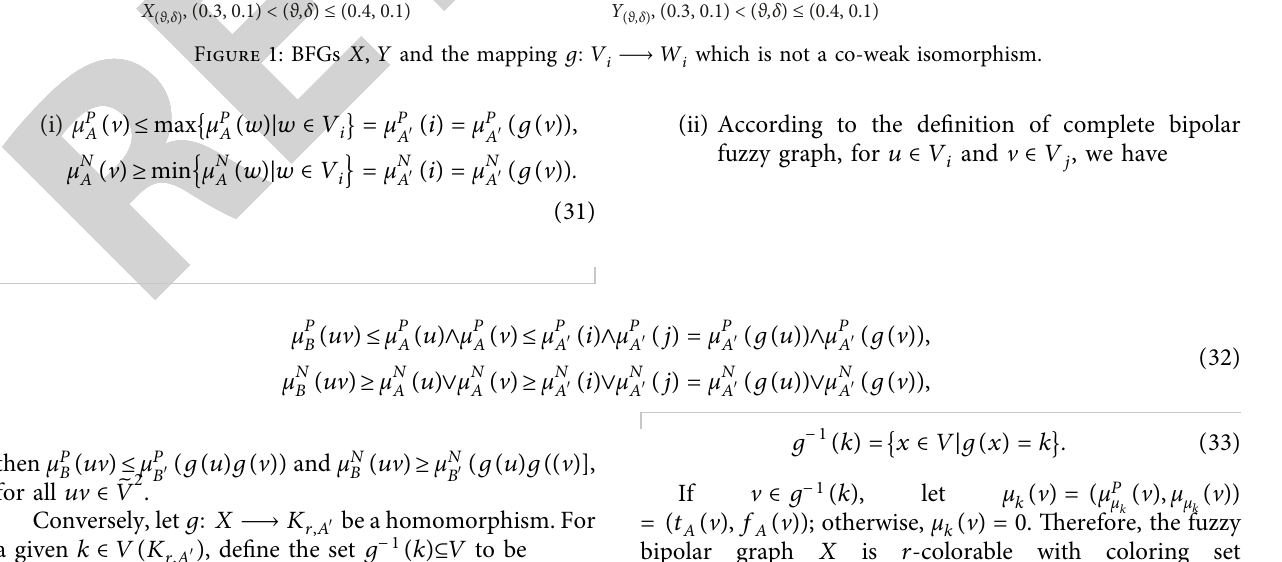
Figure 1: BFGs X , Y and the mapping g : V